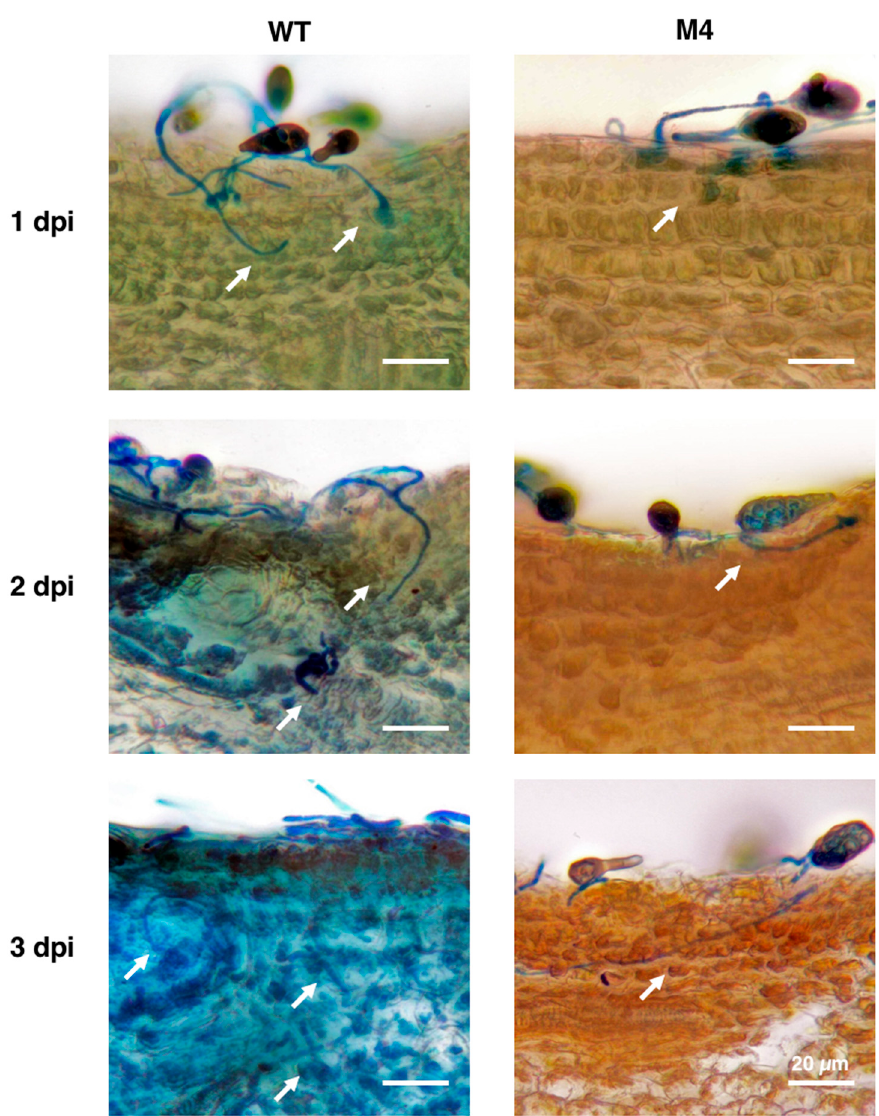
Figure 8. Pex6 deficiency leads to penetration impairment. Calamondin leaves were inoculated with conidia prepared from wild type (WT) and the ∆ pex6 -M4 mutant, thin sectioning by hands 1 to 3 days post inoculation (dpi), and observed by microscopy. Wild-type hyphae (indicated by white arrows) after lactophenol cotton blue staining were observed in the epidermal layer and mesophyll cells. Hyphae of the Δ pex6 -M4 mutant were observed only in the epidermal layer of citrus leaves. Bar = 20 µm.